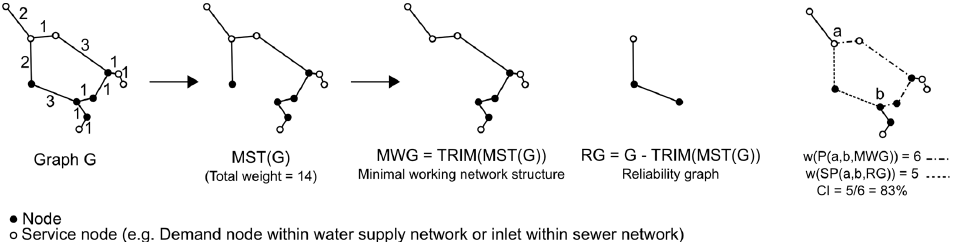
Figure 3. CI evaluation.